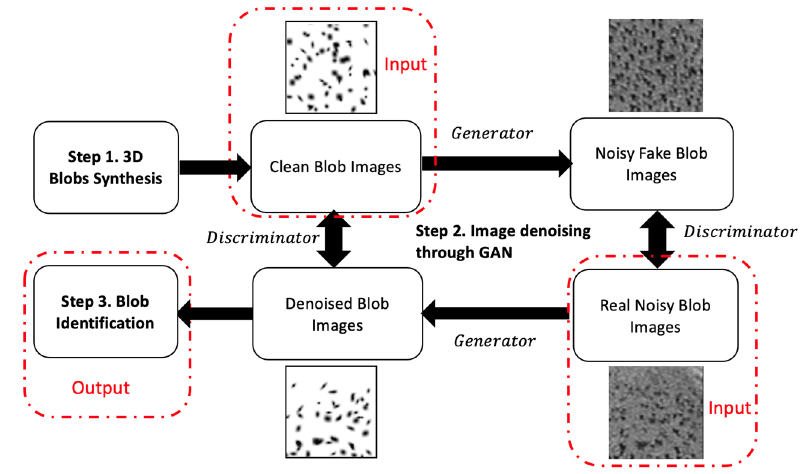
Figure 1. The overview of the BlobGAN model for blob identification.